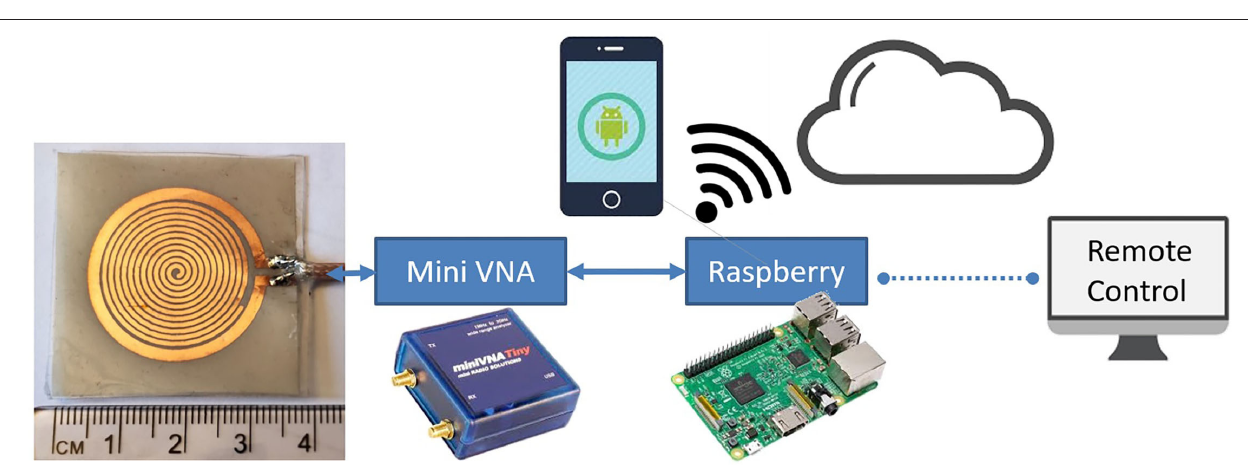
FIGURE 15 | Senseburn system integration using Sensor, MiniVNA, Power Unit, and Raspberry Pi